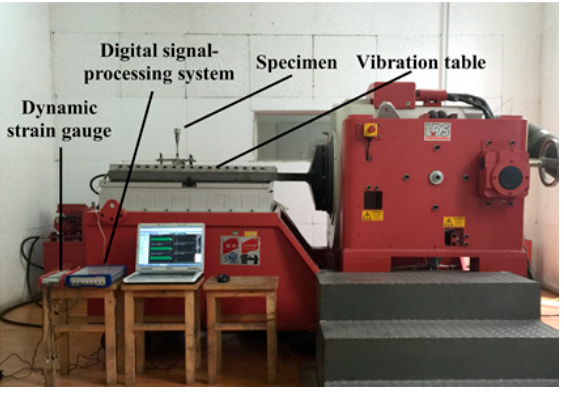
Figure 3. Dynamic stress measurement and vibratory stress relief (VSR) test setup.